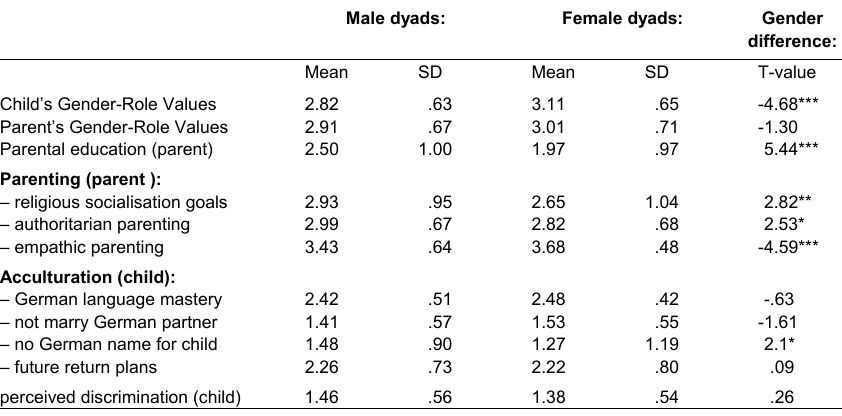
perceived discrimination (child)